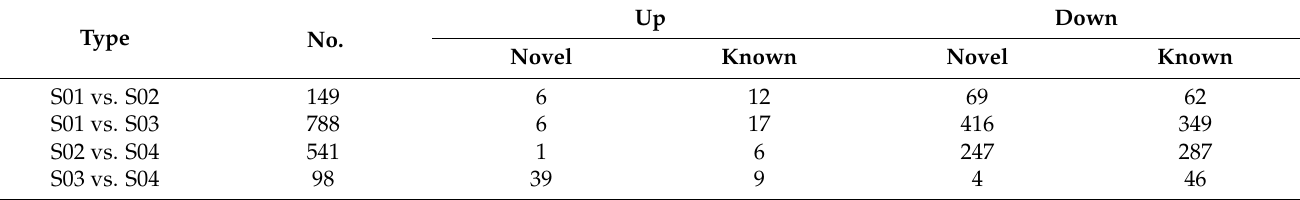
Figure 2. Mapped reads displayed on different soybean chromosomes. ( A ) S01—Nannong 10-1 mock; ( B ) S02—Nannong 10-1 at 12 h post-inoculation (hpi); ( C ) S03—06-070583 mock; ( D ) S04—06-070583 at 12 hpi. Table 3. The number of differentially expressed